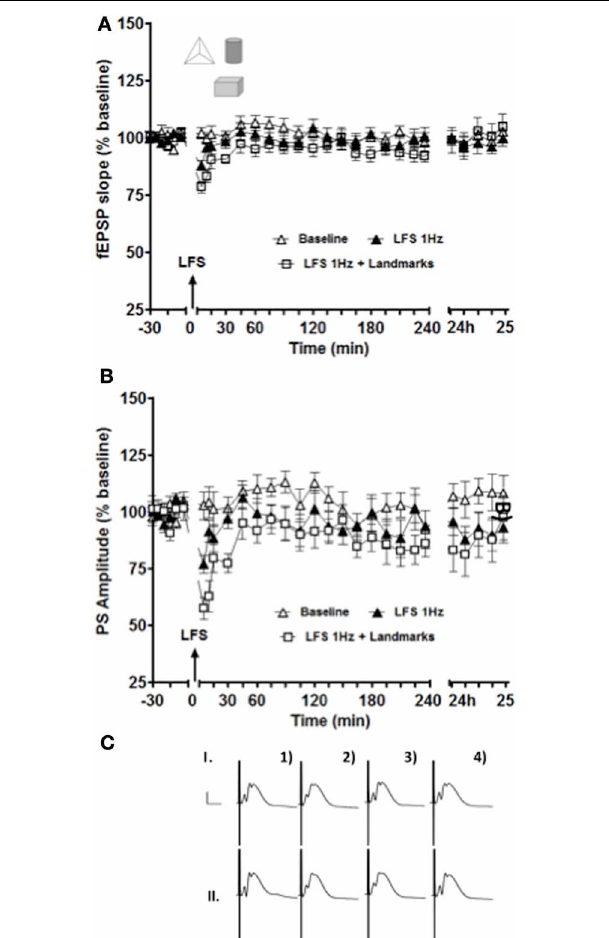
FIGURE 3 | Short-term depression of both fEPSP (A) and PS (B) amplitude was enhanced and prolonged in the intermediate DG when novel exposure to landmark cues was combined with low-frequency afferent stimulation (white squares data set) compared to low-frequency stimulation alone (black triangle data set). The white triangle data set represents results collected from the same animals ( n = 14) in a control test-pulse experiment. (C) Shows examples of analog recordings of intermediate DG potentials with (II) and without (I) landmark exposure 5min before (1), 5min after (2), 4h after (3), and 24h (4) after LFS. Vertical bar: 5mV, horizontal bar: 5ms.